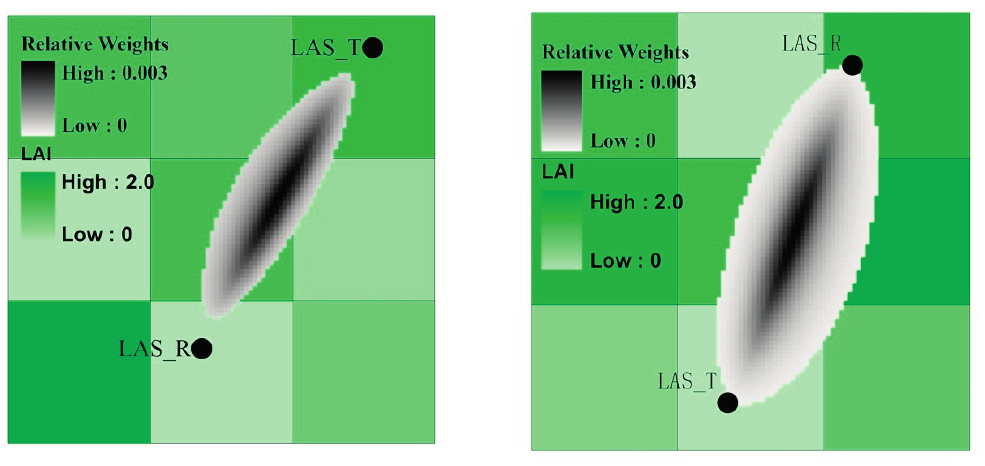
Figure 3. LAS source area overlaid with 1 km MODIS pixel (left is the Miyun site, right is the Daxing site; LAS_T is the LAS transmitter and LAS_R is the LAS receiver; the background pix is derived from MODIS LAI products,